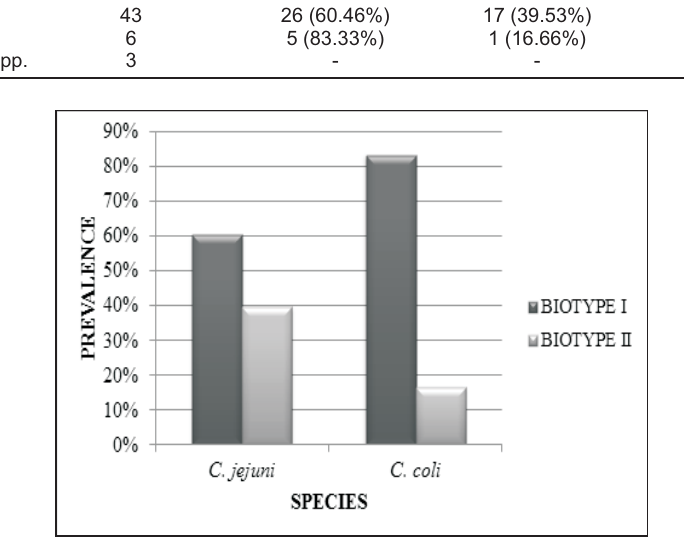
Figure-1: Prevalence of biotypes in poultry